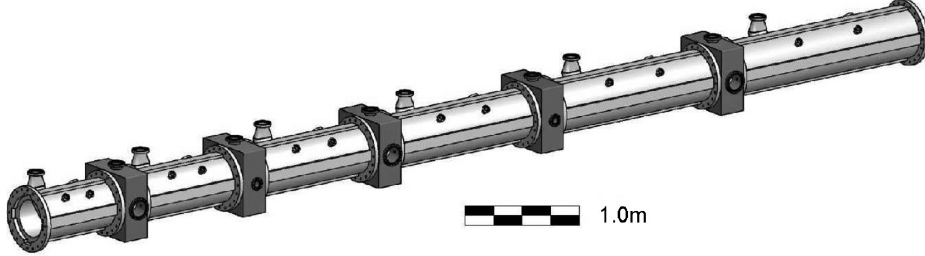
FIG. 47. Mechanical design of the second cavity of the FAIR proton